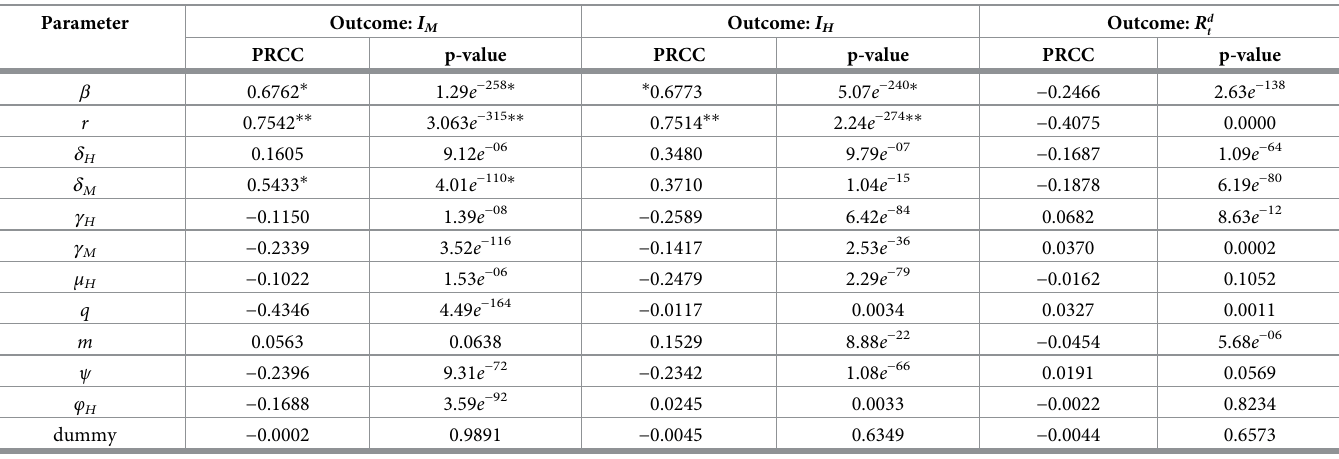
Table 4. Output from sensitivity analysis.